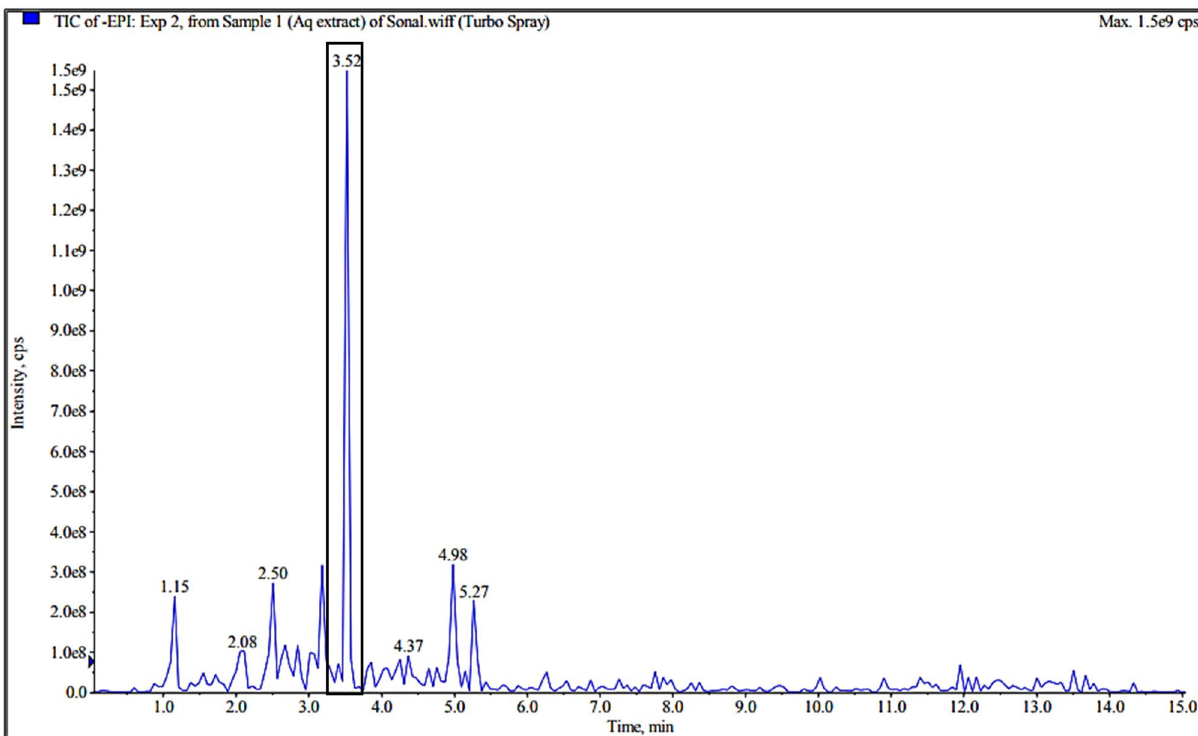
Figure 2. Total Ion Chromatogram (TIC) LC–MS analysis of compounds identified in TA extract.